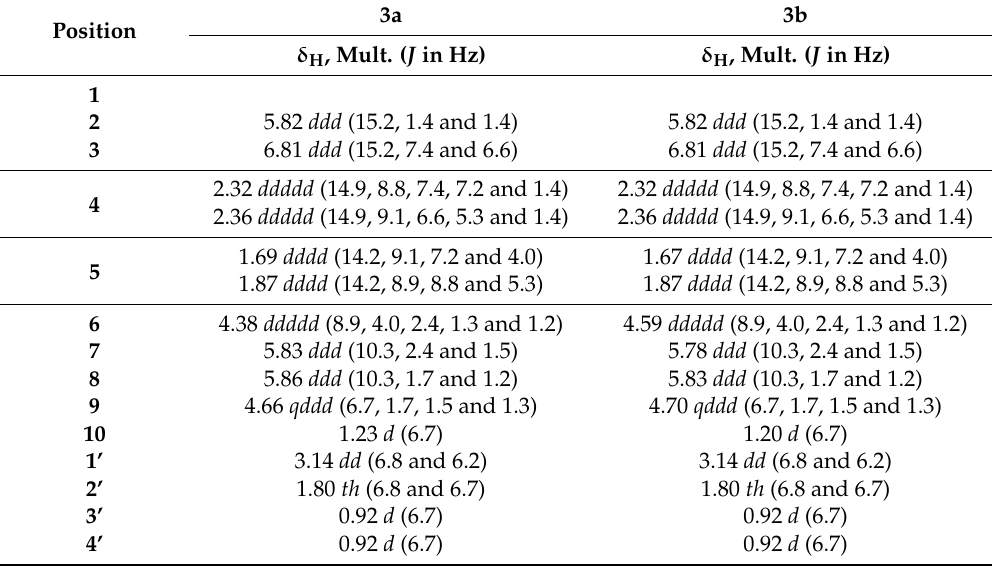
Table 1. 1 H-NMR data (CDCl 3 , 600 MHz) for compounds 3a and 3b .